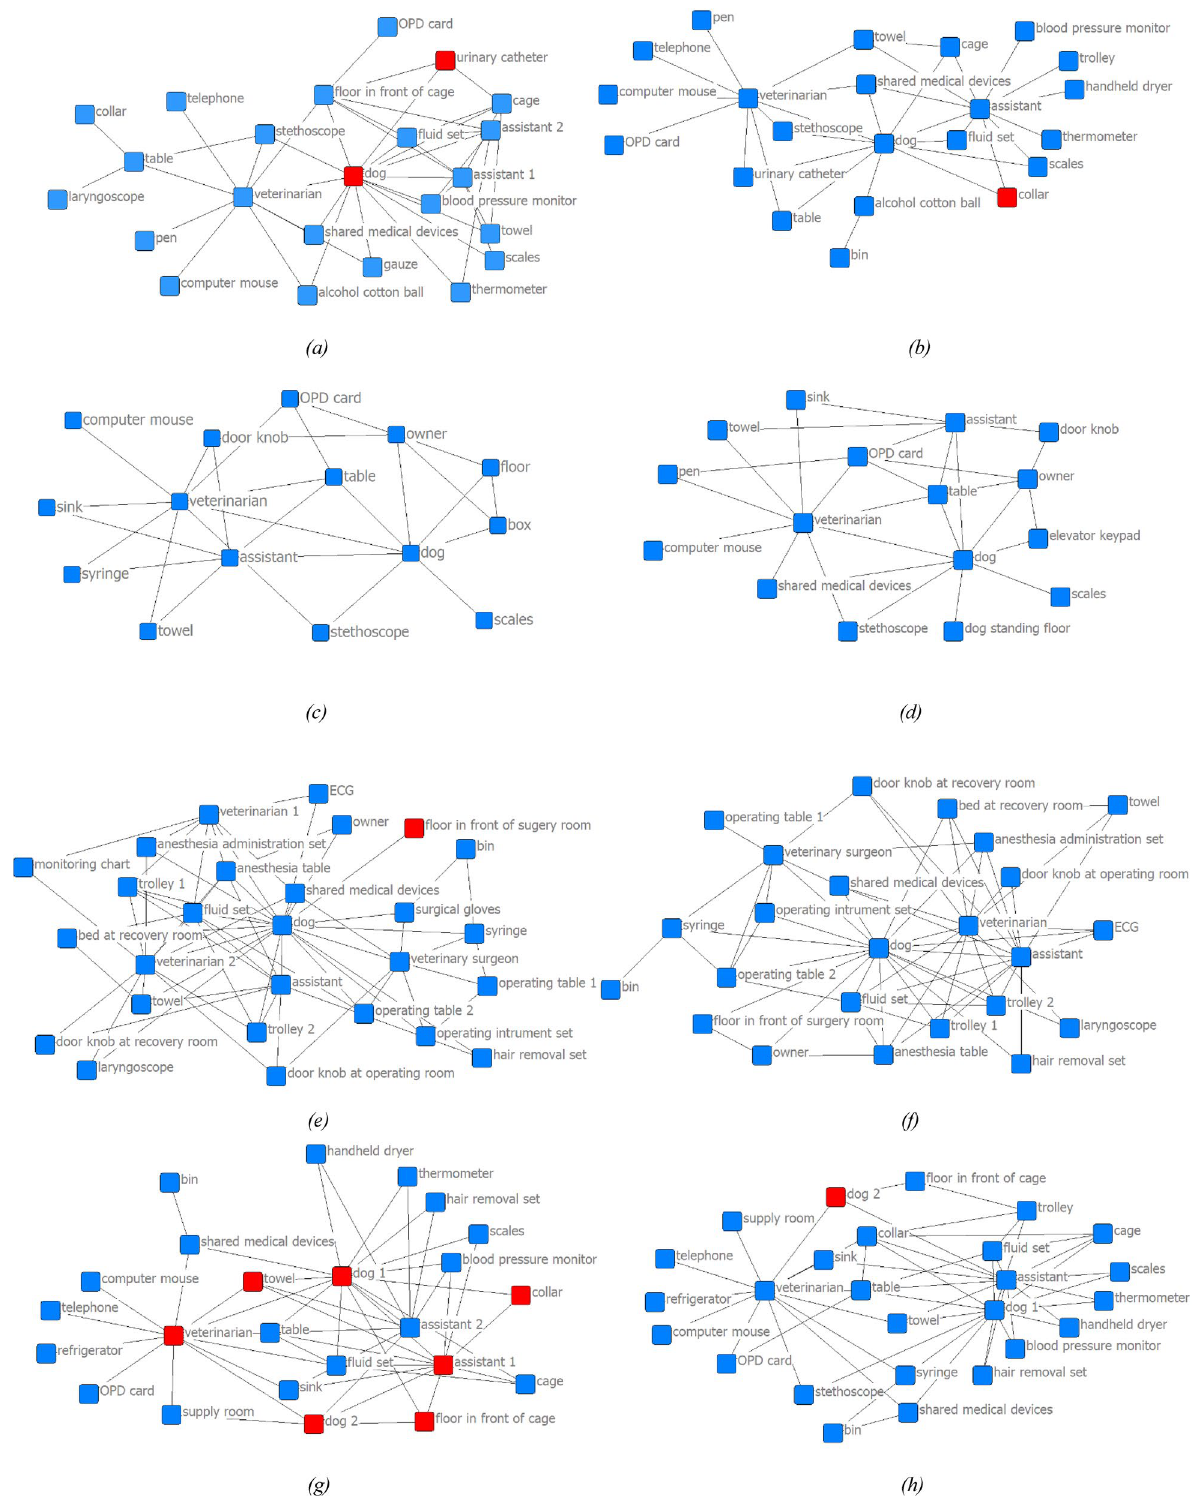
Figure 2. Sociogram of observed networks with surface swabs categorised by department and time of sampling. Red nodes represent positive E. coli samples. (a) Critical care unit: first sampling event (23 nodes, 44 ties); (b) critical care unit: second sampling event (22 nodes, 32 ties); (c) outpatient department: first sampling (15 nodes, 27 ties); (d) outpatient department: second sampling event (16 nodes, 29 ties); (e) operation room: first sampling event (27 nodes, 66 ties); (f) operation room: second sampling event (24 nodes, 60 ties); (g) ward: first sampling event (24 nodes, 53 ties); (h) ward: second sampling (26 nodes, 52 ties). The figure was generated in NetDraw 2.160 (https ://sites .googl e.com/site/netdr awsoft ware /home). https ://sites .googl e.com/site/netdr awsof tware